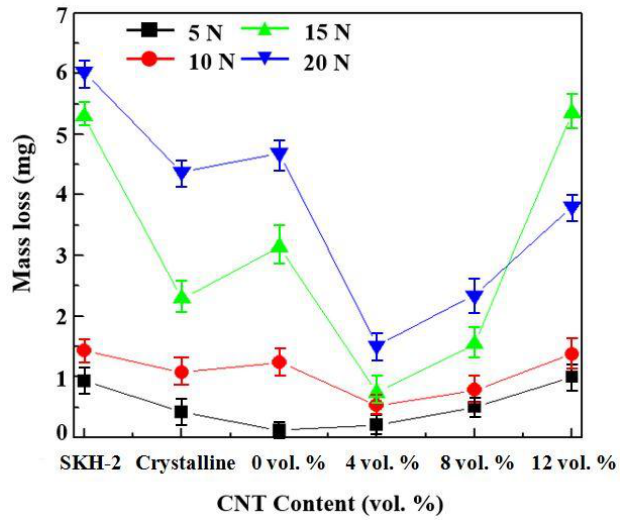
Metals 2016 , 6 , 289 8 of 10